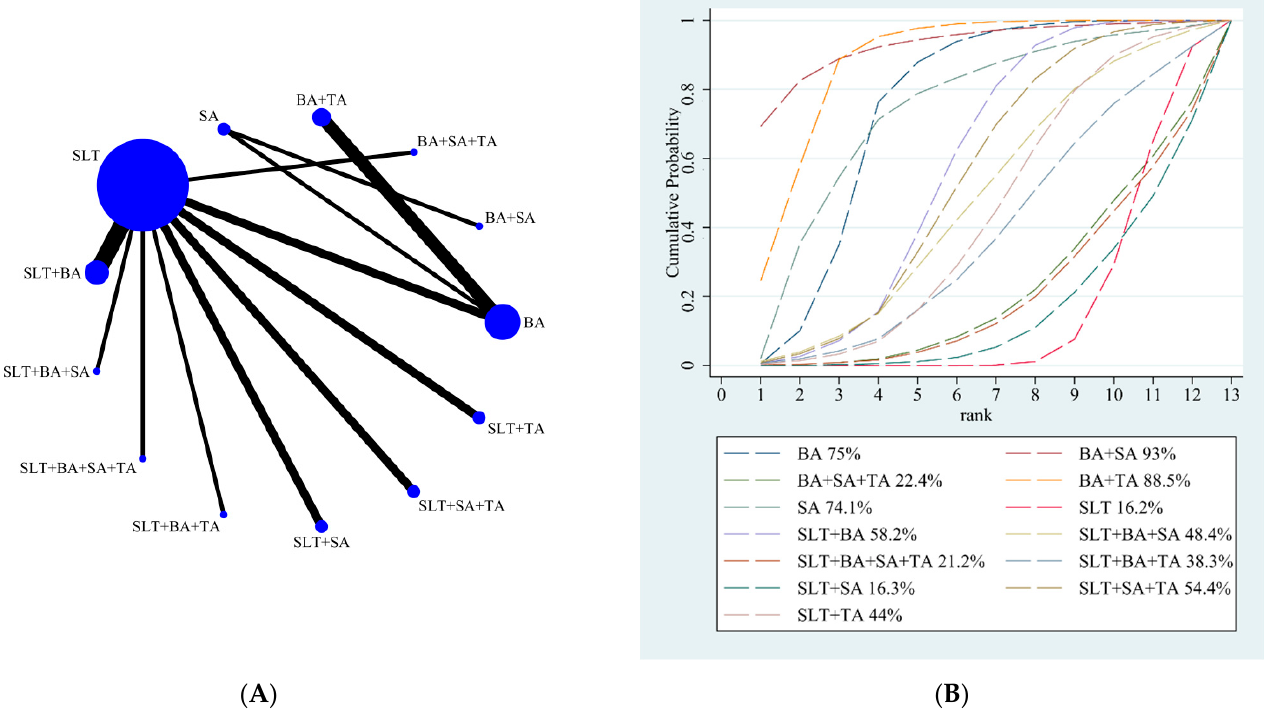
Figure 6. ( A ) NMA figure for the denomination score. ( B ) SUCRA plot for the denomination score.